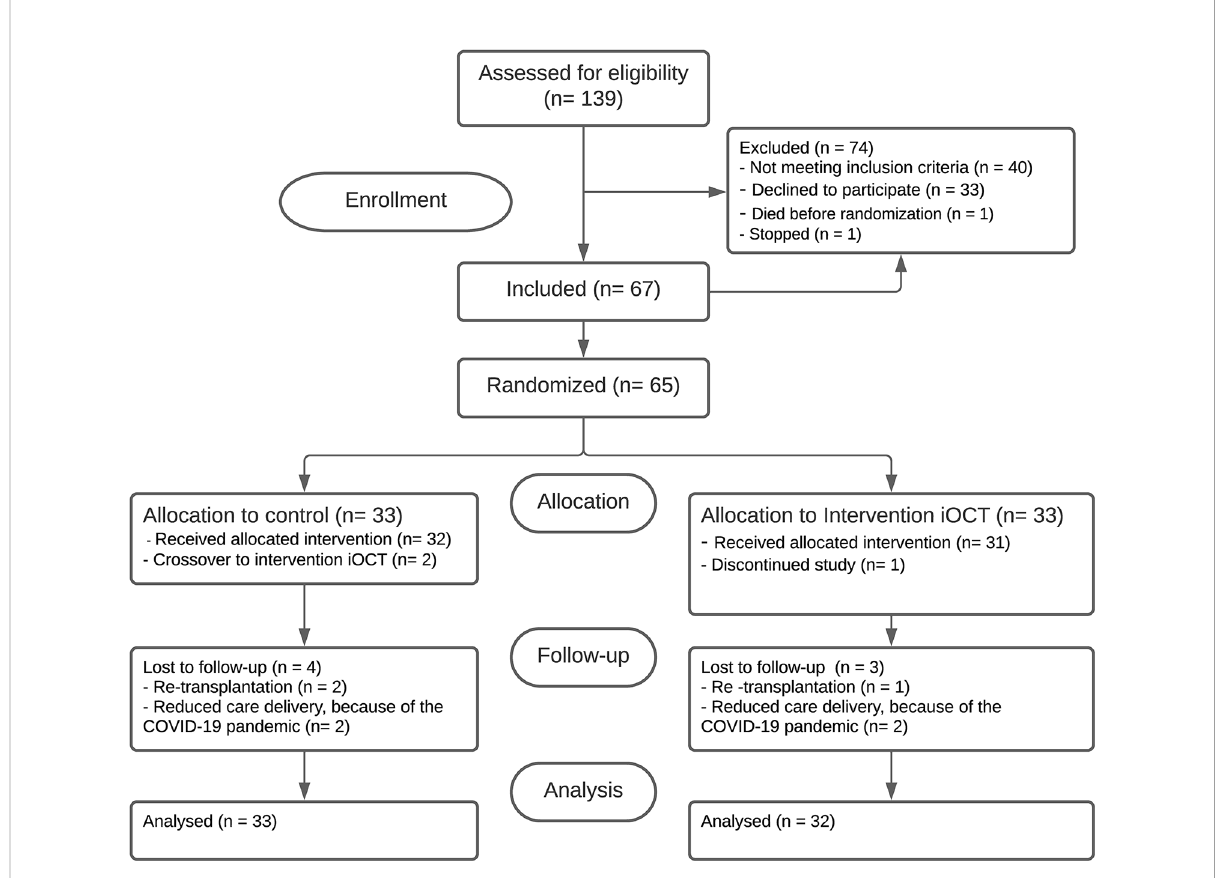
FIGURE 1 Consolidated standards of reporting trials fl